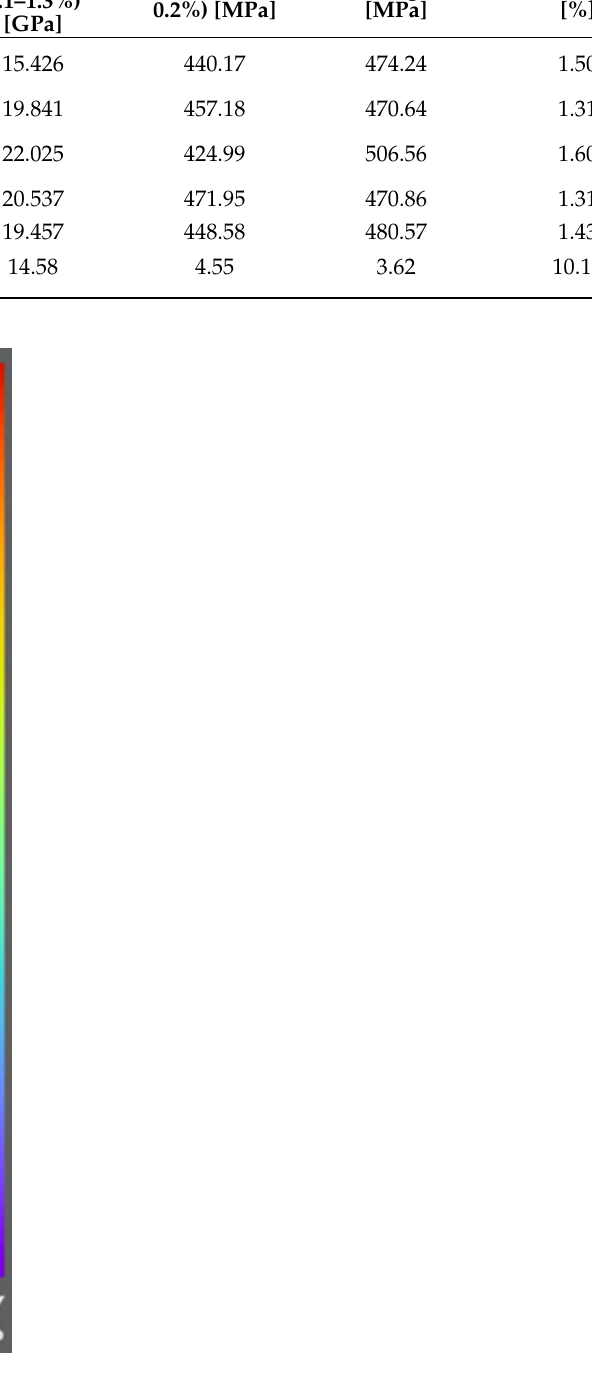
Figure 10. Maximum strain obtained for D.I.C. evaluated multi-ply tensile test specimen. The tendency of the stress to perpetuate with respect to the direction of the tensioned being clearly visible.